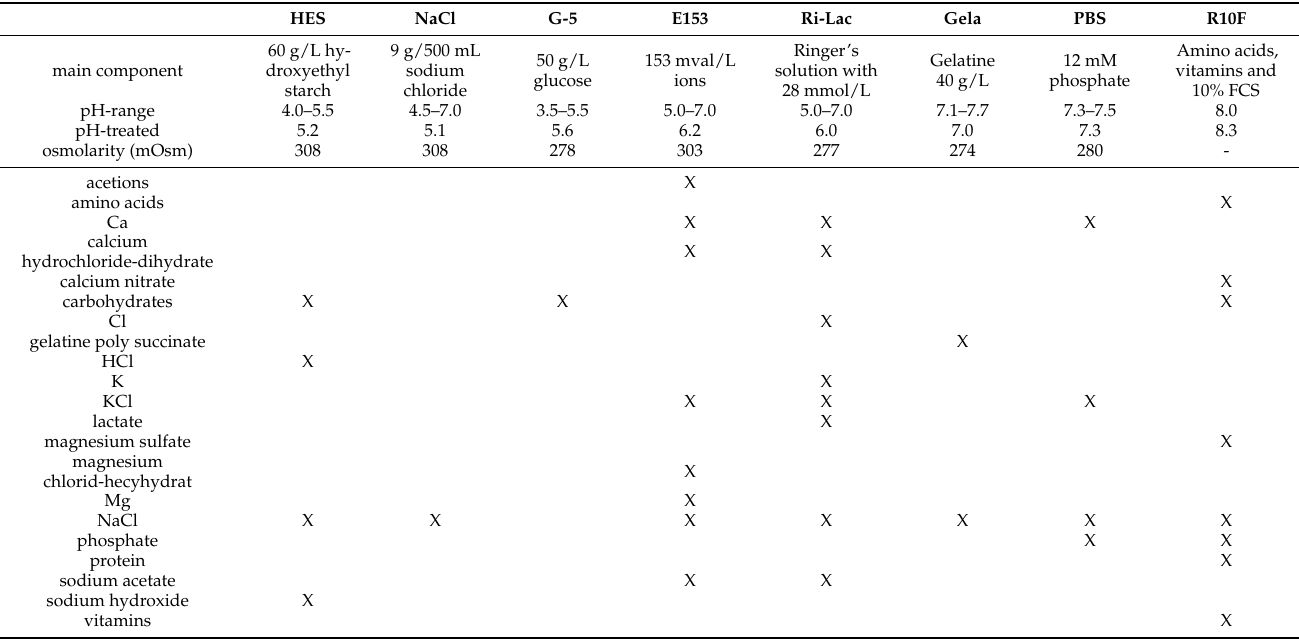
Table 1. Chemical composition of six clinically approved solutions compared to phosphate-buffered saline (PBS) and RPMI cell culture medium containing 10% fetal bovine/calf serum (R10F). Reproduced from [37]. Copyright 2019 IEEE. HES NaCl G-5 E153 Ri-Lac Gela PBS